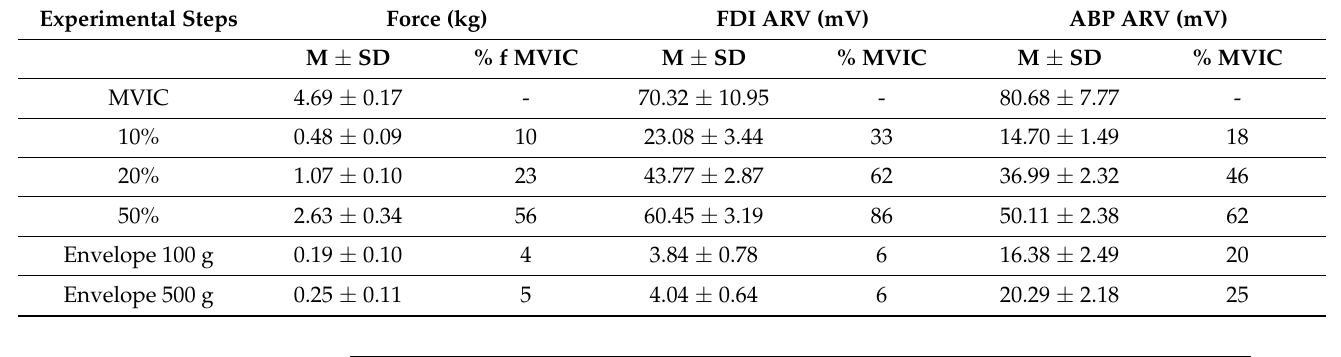
tion of the regression line is also shown in the box of Figure 2.